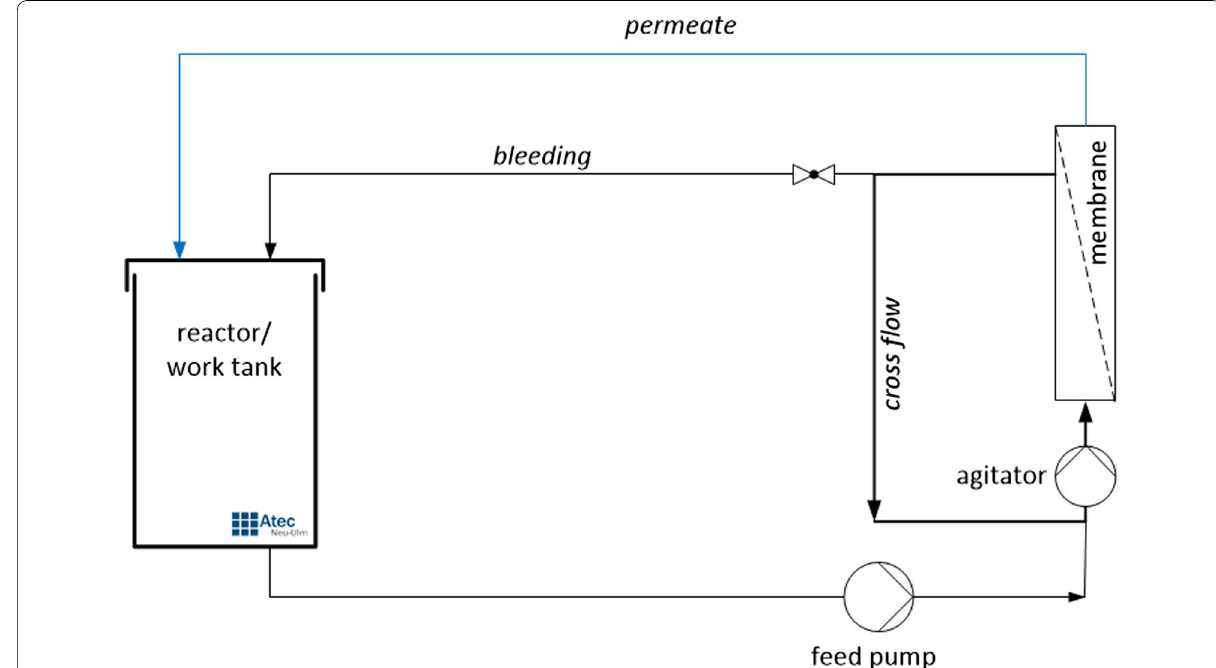
Fig. 1 Scheme of the reactor equipped with an Atec ultrafiltration